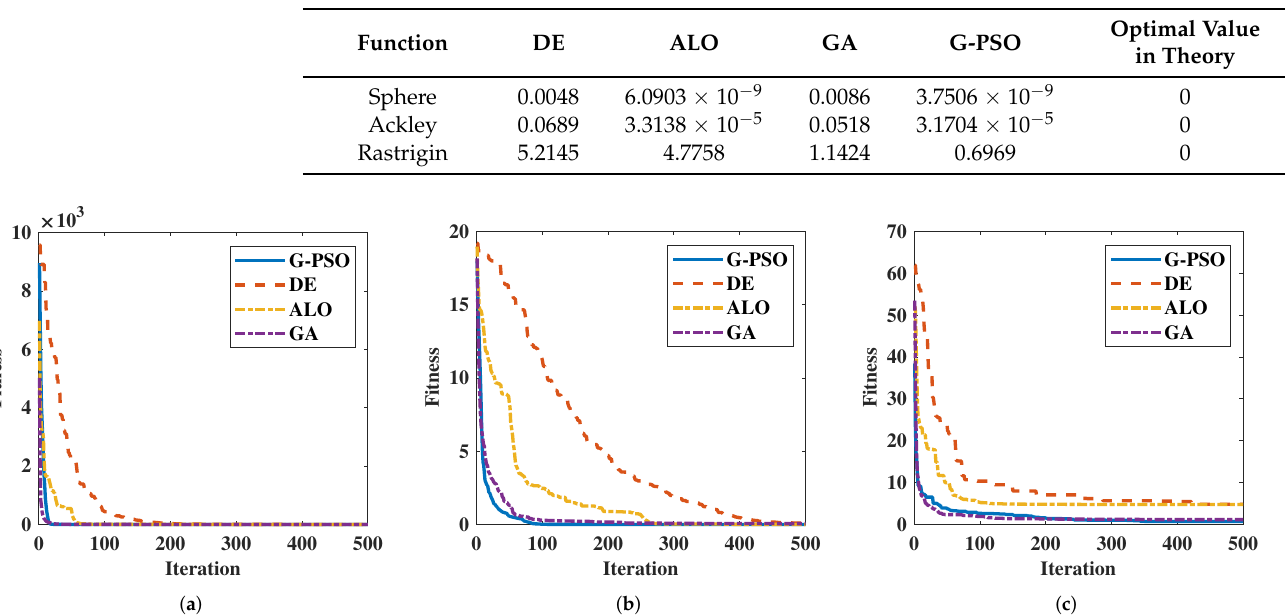
Table 2. The average value of the optimal solution of the test functions by different algorithms.